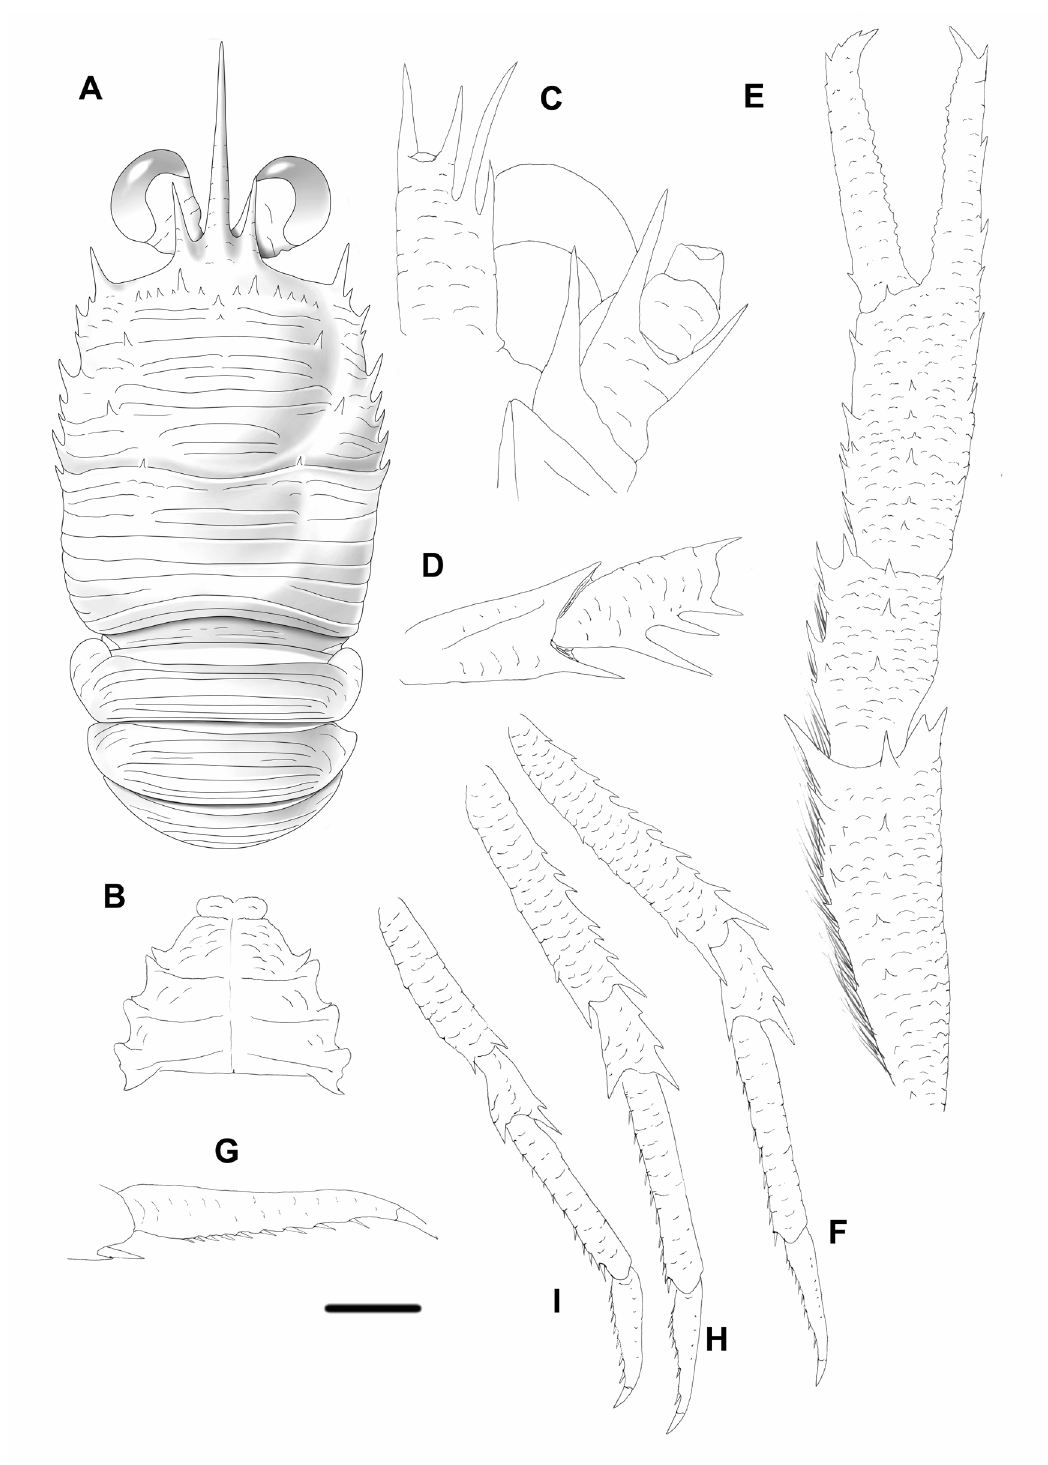
Fig. 6. Munida mesembria sp. nov., holotype, ♂, 7.7 mm (MNHN-IU-2014-13477), Mozambique. A . Carapace and abdomen, dorsal view. B . Sternal plastron. C . Cephalic region, showing antennular and antennal peduncles, ventral view. D . Right Mxp3, lateral view. E . Right P1, dorsal view. F . Right P2, lateral view. G . Dactylus of right P2, lateral view. H . Left P3, lateral view. I . Right P4, lateral view. Scale bar: A, E–F, H–I = 2.0 mm; B–D, G = 1.0